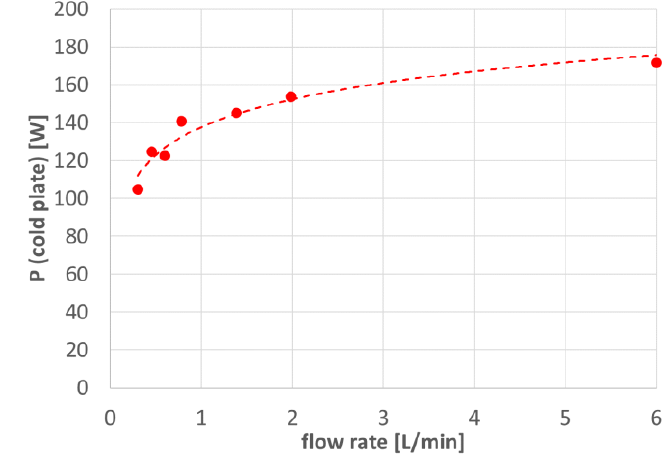
Figure 7. Heat rate transferred to the water with respect to its flow rate.